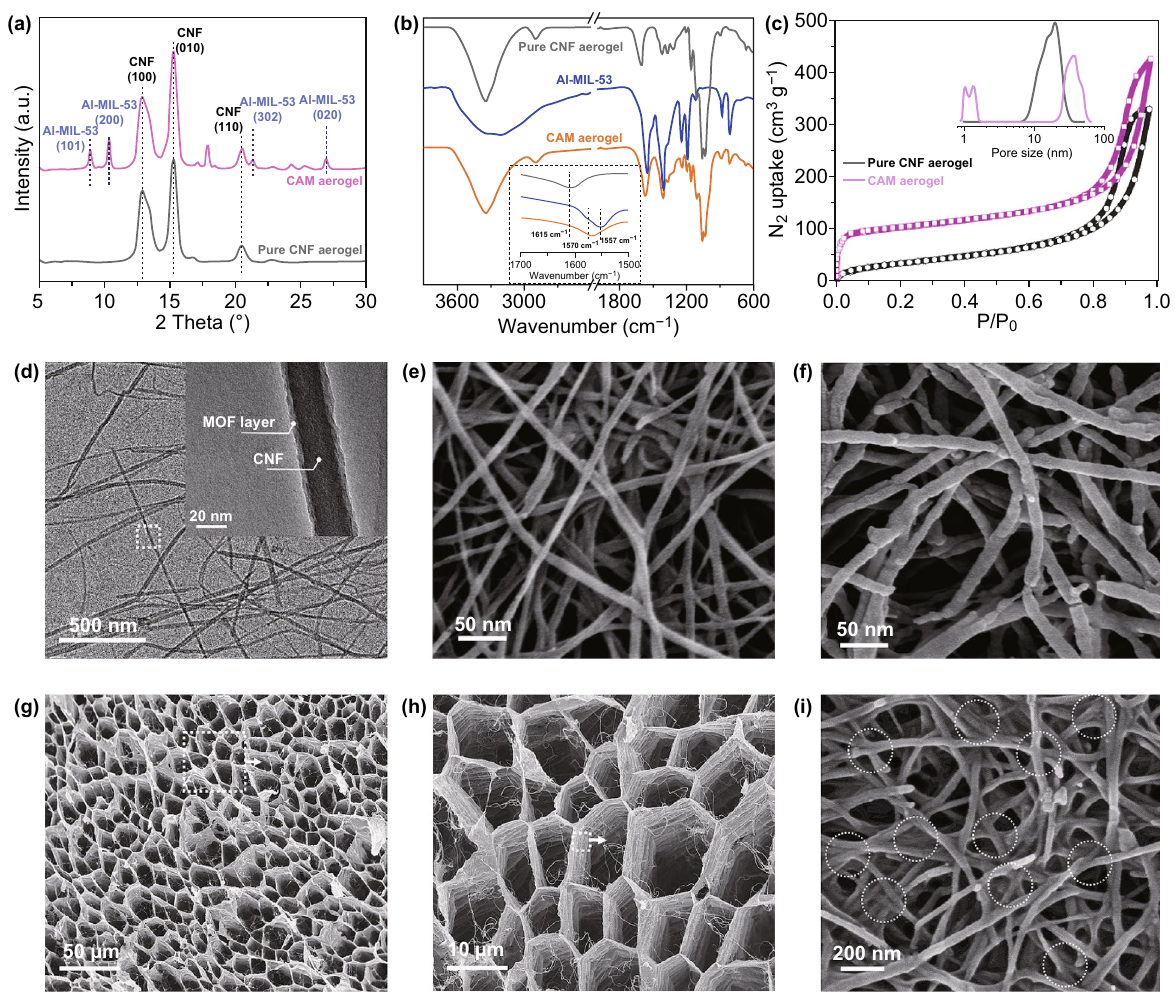
Fig. 2 a XRD patterns of the pure cellulose nanofibers (CNFs) and CNF@Al‑MIL‑53 (CAM) aerogels. b FTIR spectra of the pure CNF aero‑ gel, pure Al‑MIL‑53 powder, and CAM aerogel. c N 2 sorption isotherms and pore size distribution of the pure CNF and CAM aerogels. d TEM image of CAM nanofibers at different magnifications. High‑resolution SEM image of e the pure CNFs and f the CAM nanofibers. g–i SEM images of the CAM aerogel at different magnifications, the circled areas show the joints between the cross‑linked nanofibers. MOF = metal– organic